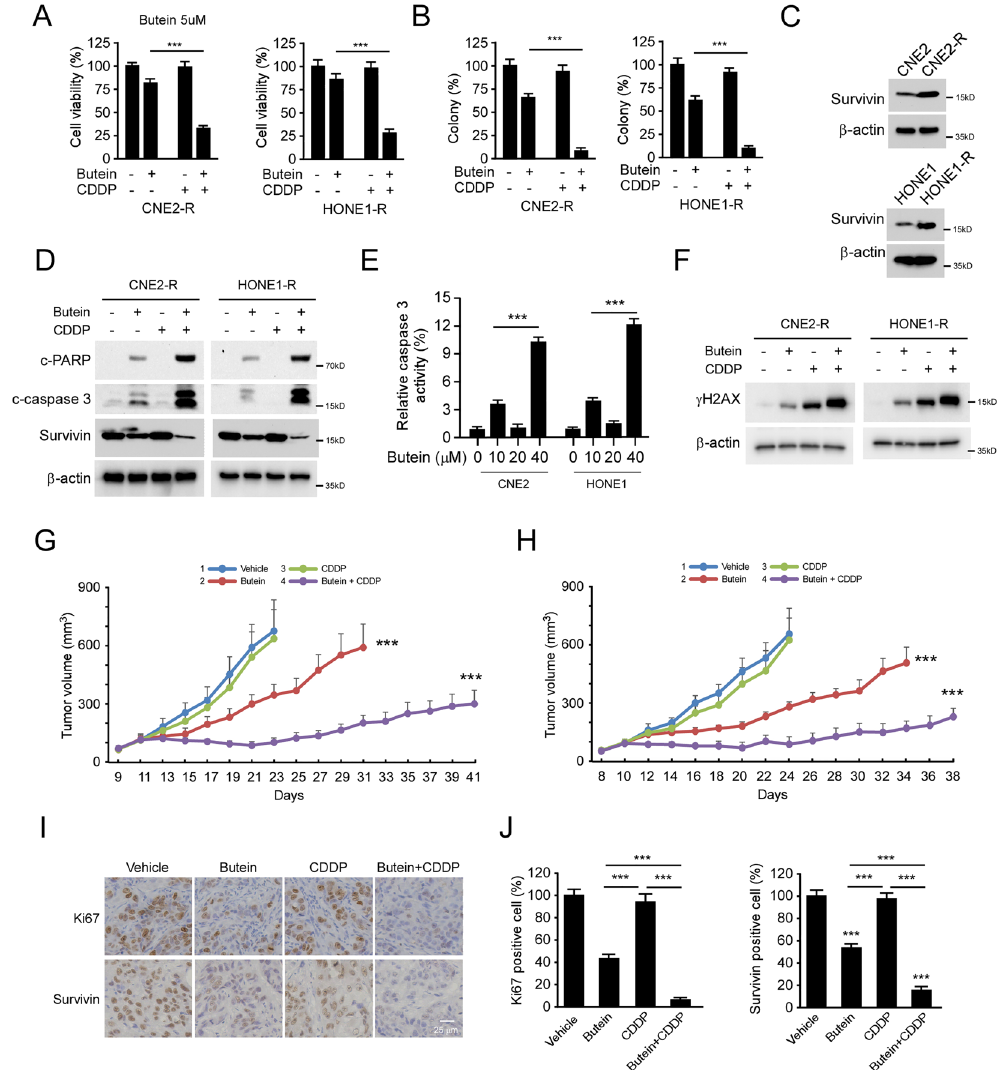
Figure 7. Butein overcomes CDDP resistance. ( A and B ) CDDP resistant CNE2-R (left) and HONE1-R (right) cells were treated with CDDP (3 µM), Butein (5 µM), or the combination for 24 h, cell viability and colony formation were examined by MTS ( A ) and soft agar ( B ) assays. ( C ) IB analysis of survivin expression in CNE2/ CNE2-IR and HONE1/ HONE1-R cells. ( D and E ) CNE2 and HONE1 cells were treated with CDDP (3 µM), Butein (5 µM), or the combination for 24 h, the WCE was subjected to IB analysis ( D ), and caspase 3 activity was examined by Caspase 3 Assay Kit ( E ). ( F ) CNE2 and HONE1 cells were treated with CDDP (3 µM), Butein (5 µM), or the combination for 24 h. The WCE was subjected to IB analysis. ( G and H ) In vivo tumor development of CNE2-R ( G ) and HONE1-R ( H ) cells treated with vehicle control, Butein, CDDP, or a Butein + CDDP combination. ( I and J ) IHC staining ( I ) and quantitative analysis ( J ) of Ki67 and survivin expression in HONE1-R-derived xenograft tumors with various treatments. *** p <